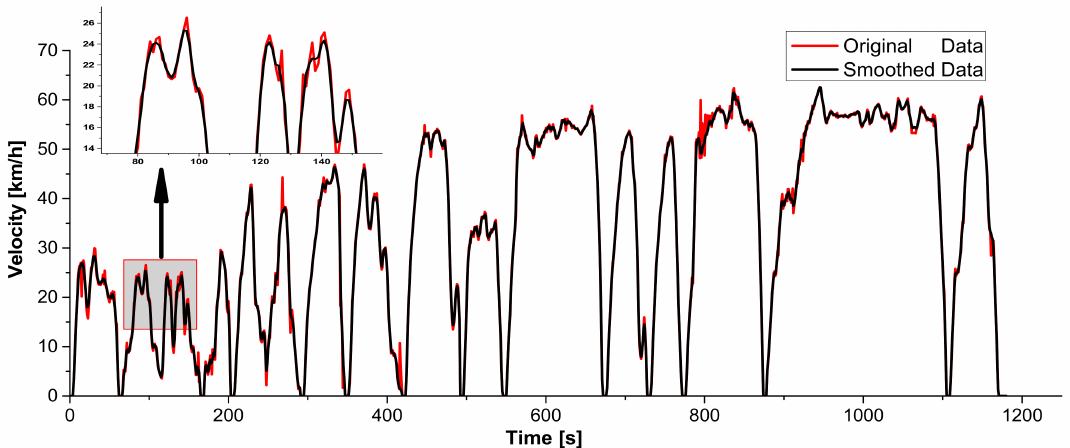
Figure 1. Comparison of ShenZhen city driving cycle (SZDC) original/smoothed velocity data.